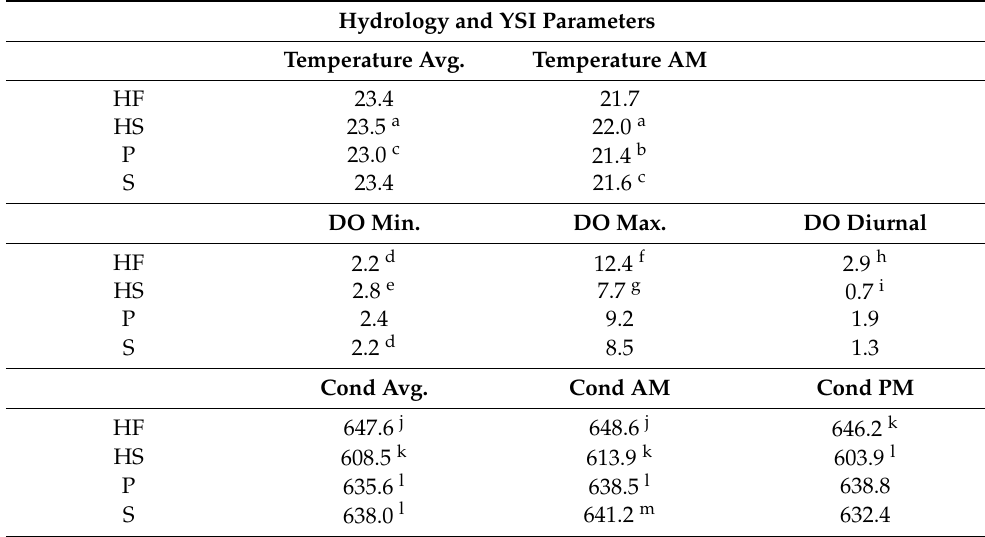
Table 3. Significant differences between YSI parameters by mesocosm hydrology type. Hydrology and YSI Parameters Temperature